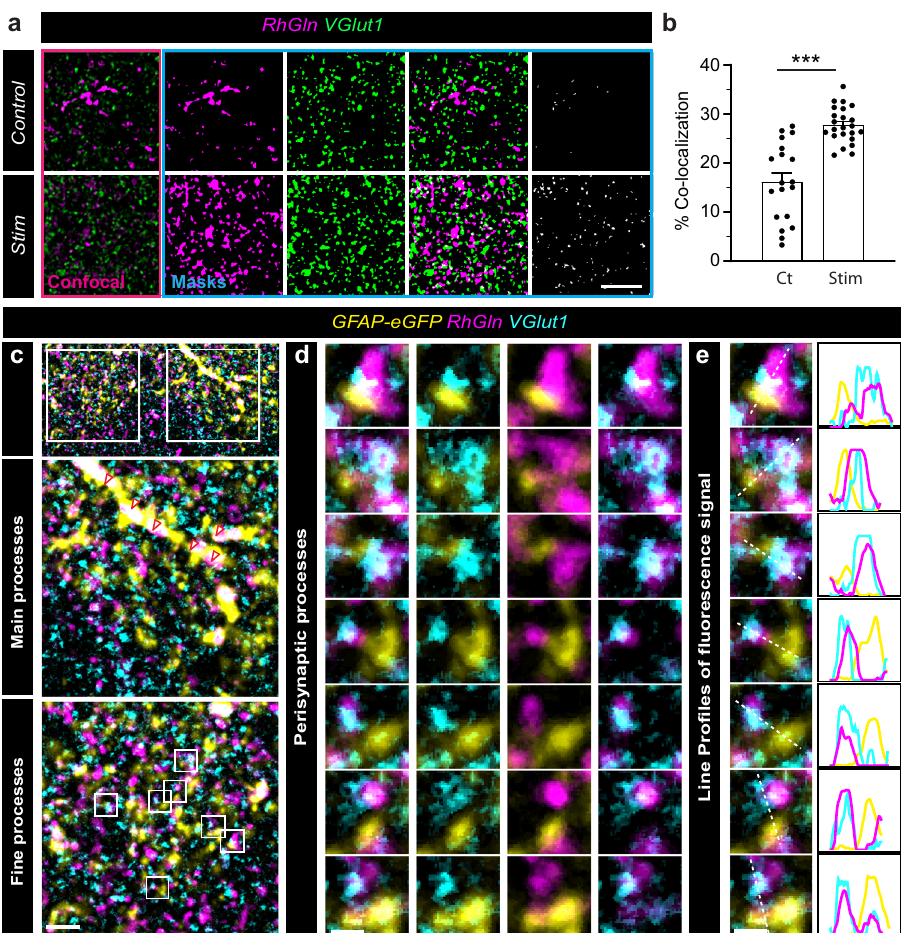
Fig. 4 Astroglial RhGln enters presynaptic compartments upon synaptic activity. a Sample confocal (pink box) and binary images (blue box) showing that after dialysis of a single astrocyte with RhGln (0.8 mM, 20 min), RhGln-labeled puncta (magenta) are observed and show increased co-localization with the glutamatergic presynaptic marker VGlut1 (green) under repetitive synaptic stimulation (Stim; 10 Hz, 30 s every 3 min for 20 min). b Bar graph (mean ± SEM) showing % co-localization normalized to total area of RhGln- fi lled structures for Ct ( n = 19 fi elds, 3 independent experiments) and Stim ( n = 23 fi elds, 3 independent experiments, p < 0.0001, two-tailed unpaired Student ’ s t -test) conditions. c , d STED super-resolution imaging con fi rmed co- localization of VGlut1 (cyan) with RhGln (magenta) found directly next to an astroglial compartment (yellow) after dialysis of a GFAP-eGFP expressing astrocyte (yellow) with RhGln (0.8 mM, 20 min) during repetitive synaptic stimulation, as shown in the sample images ( c ). Higher magni fi cations of regions containing either main (middle panel) or fi ne (lower panel) astroglial processes are shown. Arrowheads denote accumulation of RhGln along a main process. d Representative images containing perisynaptic astroglial processes marked by boxes in c (lower panel). e Line pro fi les measured along individual white dotted lines for individual channels to illustrate co-localization. Scale bars: a 5 µ m; c 2 µ m; d , e 0.5 µ m. Asterisks indicate statistical signi fi cance (*** p < 0.0001). Representative images a are from replicates described in ( b ); and c – e are from n = 3 replicates. Source data are provided as a Source data fi